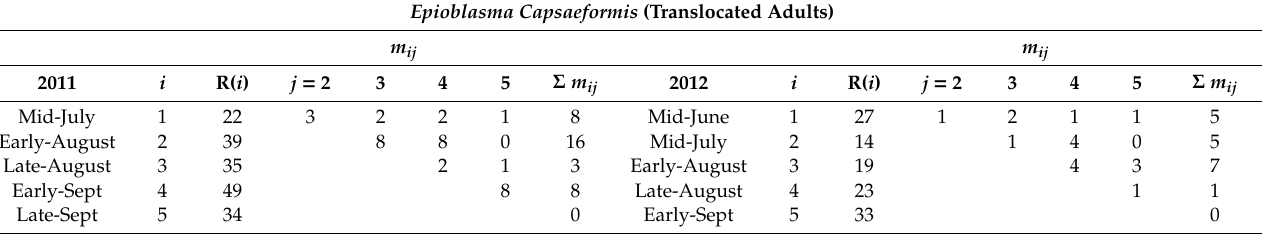
Table 4. Summary of initial captures and recaptures within the 2011 and 2012 capture-mark-recapture study periods at Cleveland Islands in the Upper Clinch River, Russel County, Virginia. i = sampling occasion, j = recapture occasion, R( i ) = number of unique individuals captured and released on sampling occasion i , m ij = number of marked individuals released during the i th sampling occasion that were recaptured in the j th